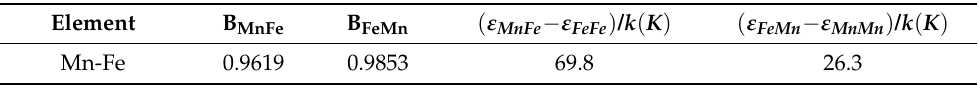
Table 5. The interaction values of B MnFe , B FeMn , θ MnFe , and θ FeMn in liquid Mn-Fe binary alloys at 177 K. Element B MnFe B FeMn ( ε MnFe − ε FeFe ) / k ( K ) ( ε FeMn − ε MnMn ) / k ( K ) Mn-Fe 0.9619 0.9853 69.8